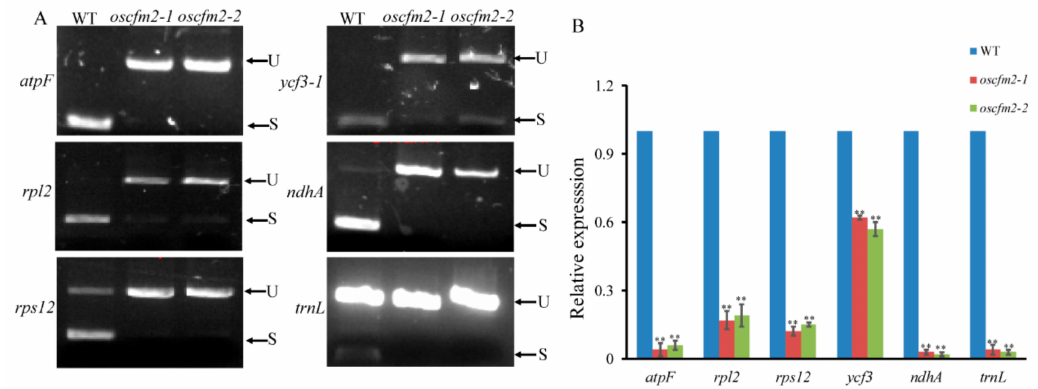
Figure 8. Intron splicing and gene expression analysis. ( A ) Splicing analysis of chloroplast genes introns in WT and oscfm2-1 and oscfm2-2 mutants. S indicates spliced transcripts. U indicates unspliced transcripts. ( B ) Expression analyzed of atpF , rpl2 , rps12 , ycf3 , ndhA , and trnL in WT and mutants. Values represent the mean ± SD (n = 3). ** p < 0.01 by Student’s